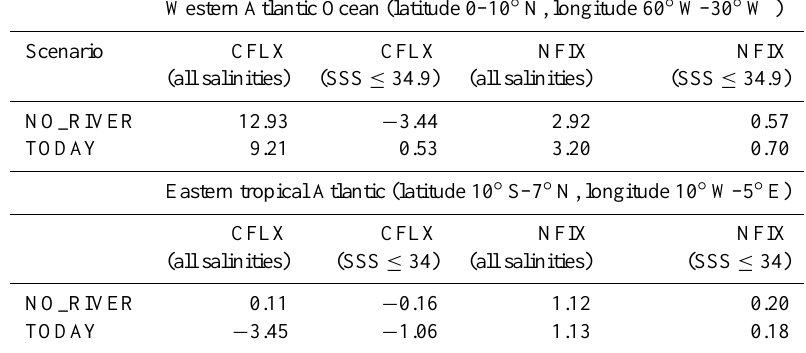
Table 4. Modeled regional sea-to-air CO 2 fluxes (CFLX, in TgCa − 1 ) and N-fixation (NFIX, in TgNa − 1 ) in the western (lat: 0 ◦ :10 ◦ N, lon: 60 ◦ W:30 ◦ W) and eastern tropical Atlantic Ocean (lat: 10 ◦ S:7 ◦ N, lon: 10 ◦ W:5 ◦